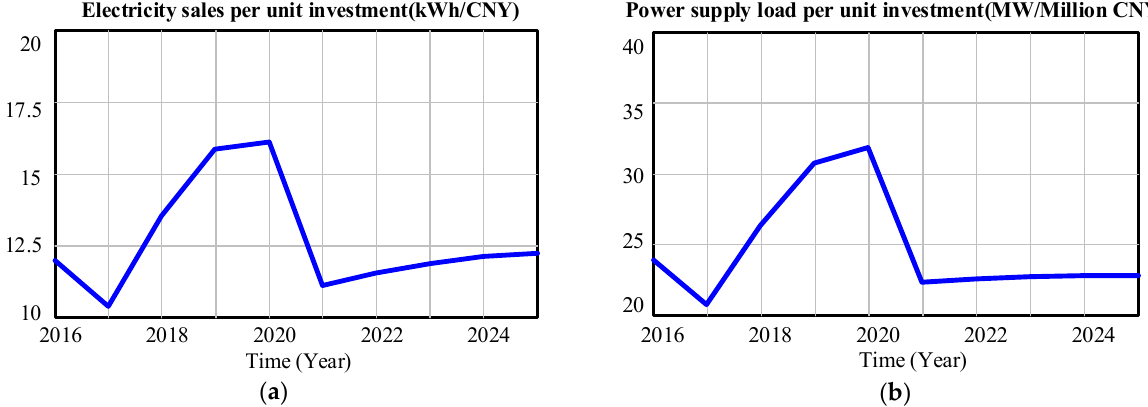
Figure 10. ( a ) The predicted value of the proportion of electricity sales per unit investment from 2016 to 2025; ( b ) the Predicted value of power supply load per unit investment from 2016 to 2025.